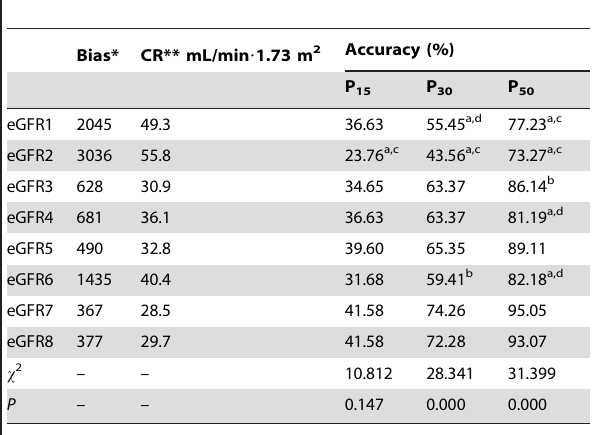
*Bias, the area between the Bland-Altman regression line and the zero difference line; arbitrary unit, i.e., (mL/min ? 1.73 m 2 ) 2 . **CR, Coefficient of Repeatability, equal to the difference between the mean difference and the 95% upper limit of agreement. a: vs. eGFR7, by Pearson x 2 test, P , 0.01: b: vs . eGFR7, by Pearson x 2 test, P , 0.05; c: vs. eGFR8, by Pearson x 2 test, P , 0.01; d: vs. eGFR8, by Pearson x 2 test, P ,